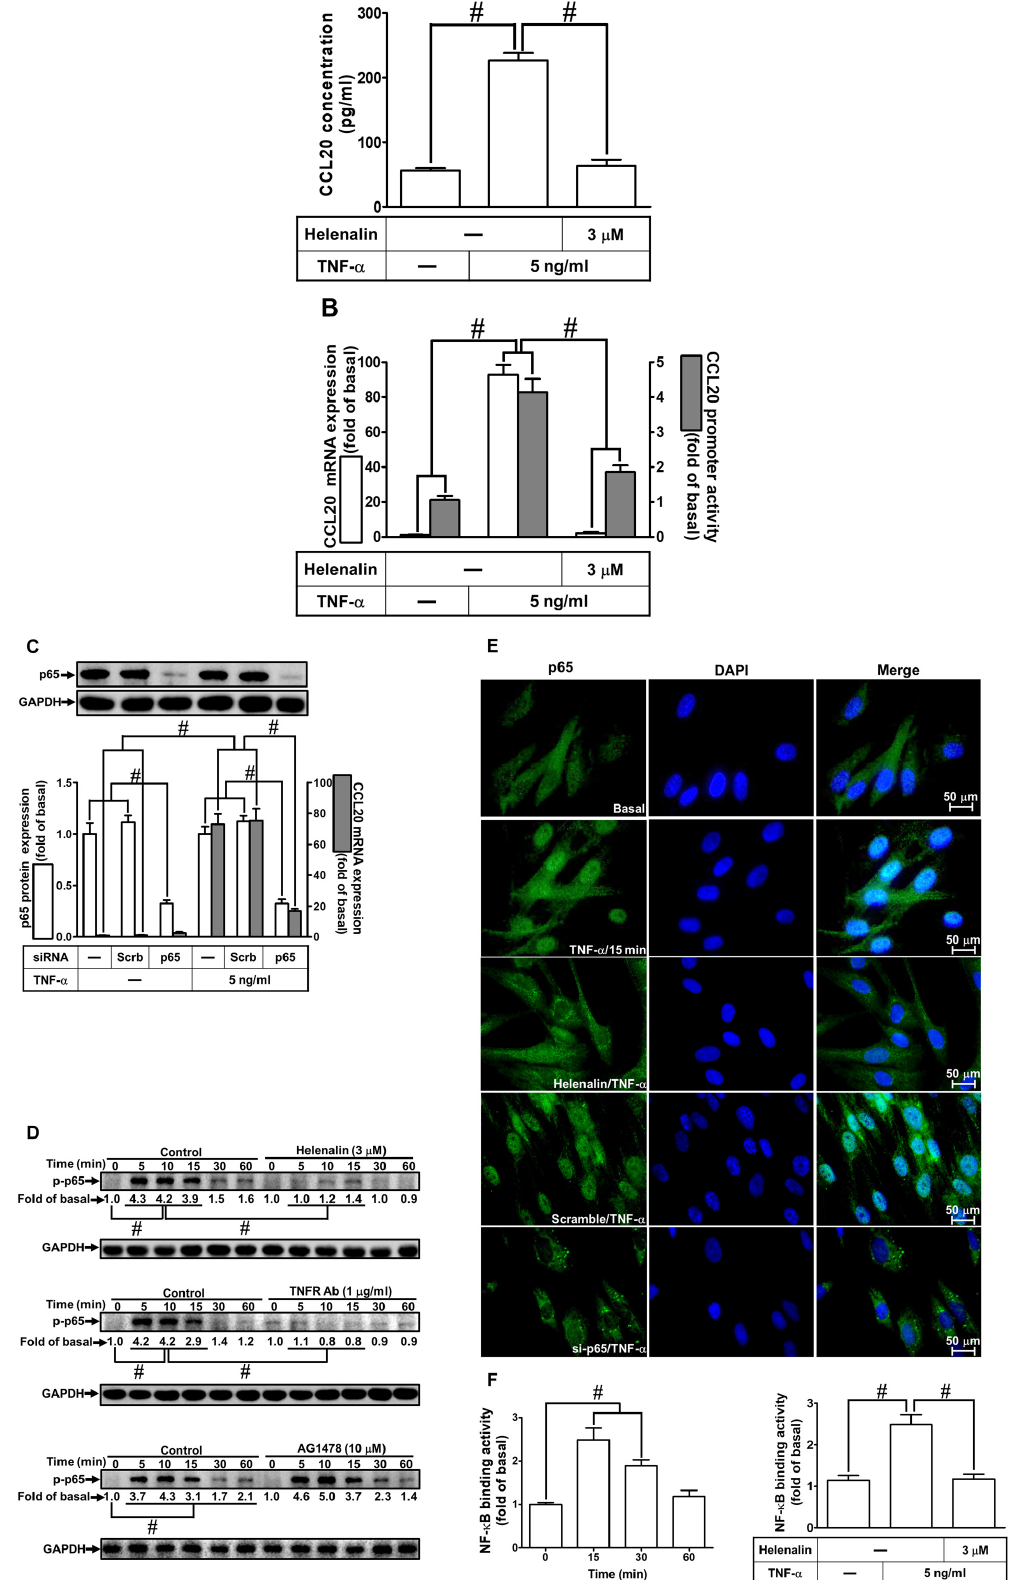
Figure 7. Involvement of NF- κ B p65 in TNF- α -induced CCL20 expression. ( A ) Cells were pretreated with 3 μ M helenalin for 1 h and then incubated with 5 ng/mL TNF- α for 12 h. The conditioned media were utilized to determine the CCL20 level via an ELISA kit. ( B ) Cells were pretreated with 3 μ M helenalin for 1 h and then incubated with 5 ng/mL TNF- α for indicated time intervals. The mRNA levels and promoter activity of CCL20 were determined by real-time PCR (2 h) and promoter assay (4 h), respectively. ( C ) Cells were transfected with scrambled or p65 siRNA and then incubated with TNF- α for 2 h. The mRNA levels of CCL20 were determined by real-time PCR. The protein levels of p65 were determined by Western blot with GAPDH as a loading control. ( D ) Cells were pretreated